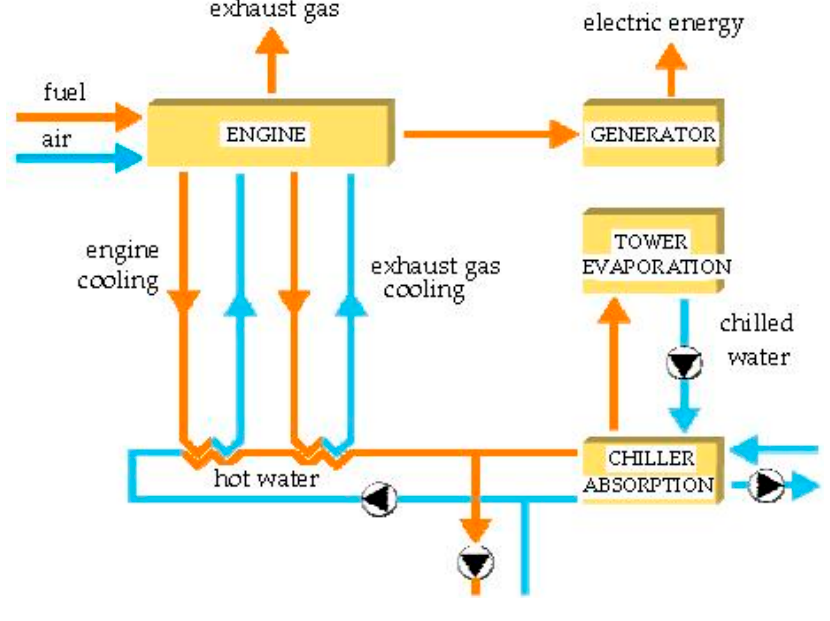
Figure 8. ASI trigeneration plant scheme.